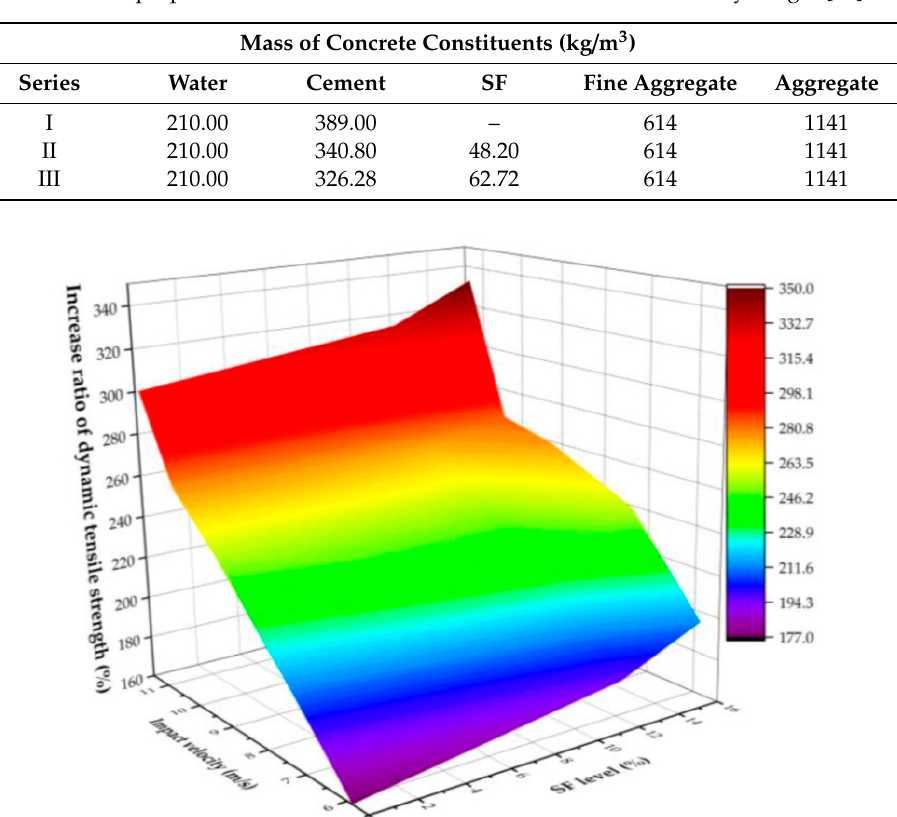
Table 1. The proportion of concrete constituents with different SF levels by weight [67].